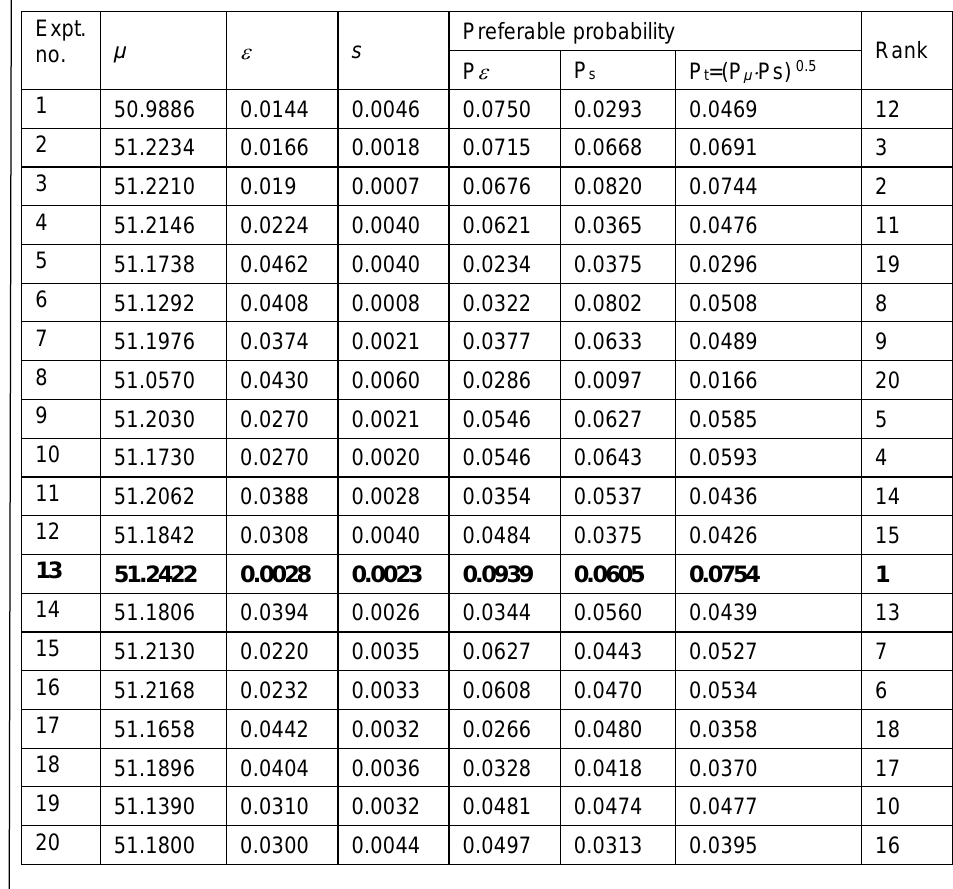
Table 5 – Assessed results together with the preferable probabilities and ranks Таблица 5 – Результаты анализа с предпочтительными вероятностями и Табела 5 – Анализирани резултати са пожељним вероватно-ћама и